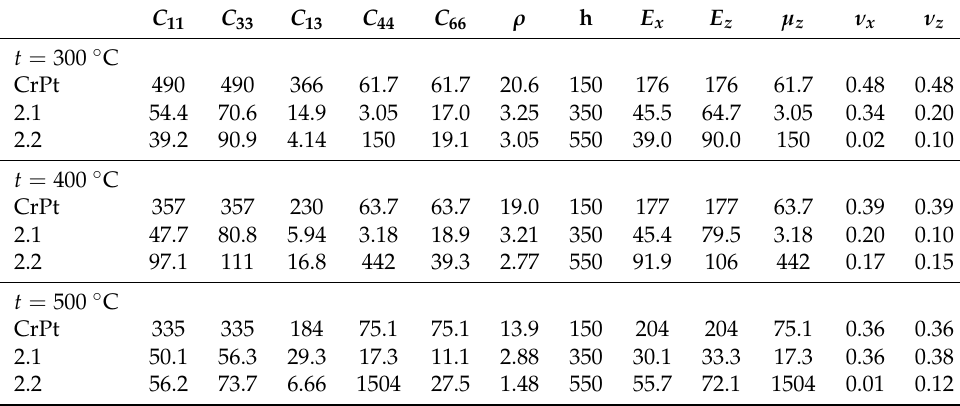
Table 4. Effective parameters of the samples with the same NW “ pyramidal ” morphology (Figure 5a) and h 3 =